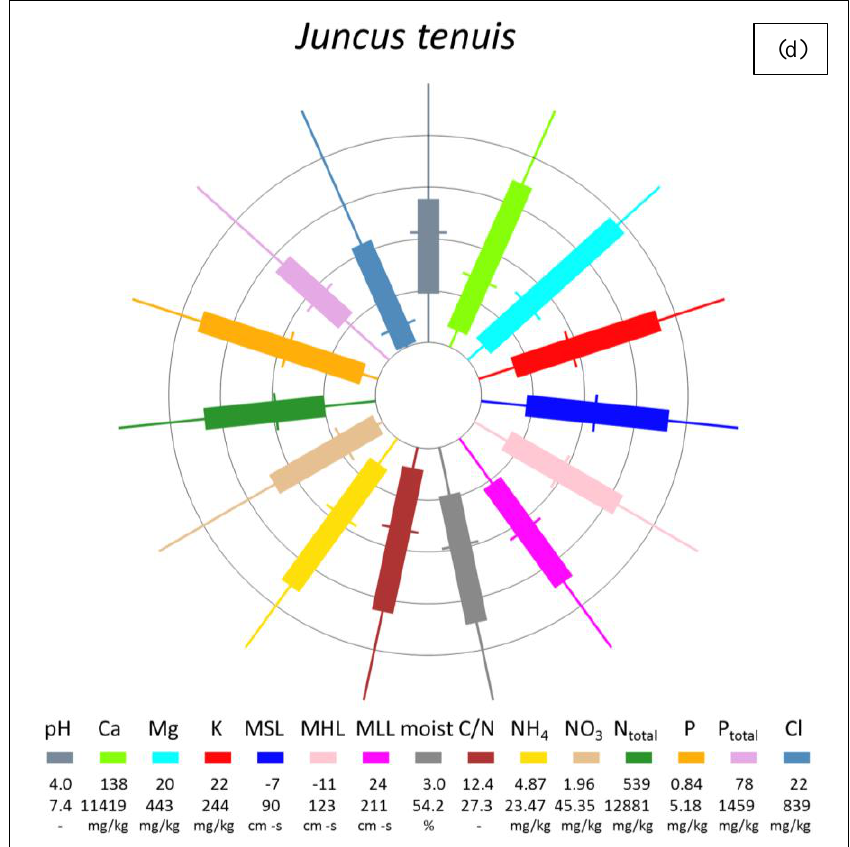
Figure 2. Abiotic ranges for the indigenous species Cirsium dissectum (L.) Hill (meadow thistle, Figure 2a), Agrostis stolonifera L. (creeping bentgrass, Figure 2b) and the neophytes Impatiens parviflora DC. (Small balsam, Figure 2c) and Juncus tenuis (slender rush, Figure 2d).